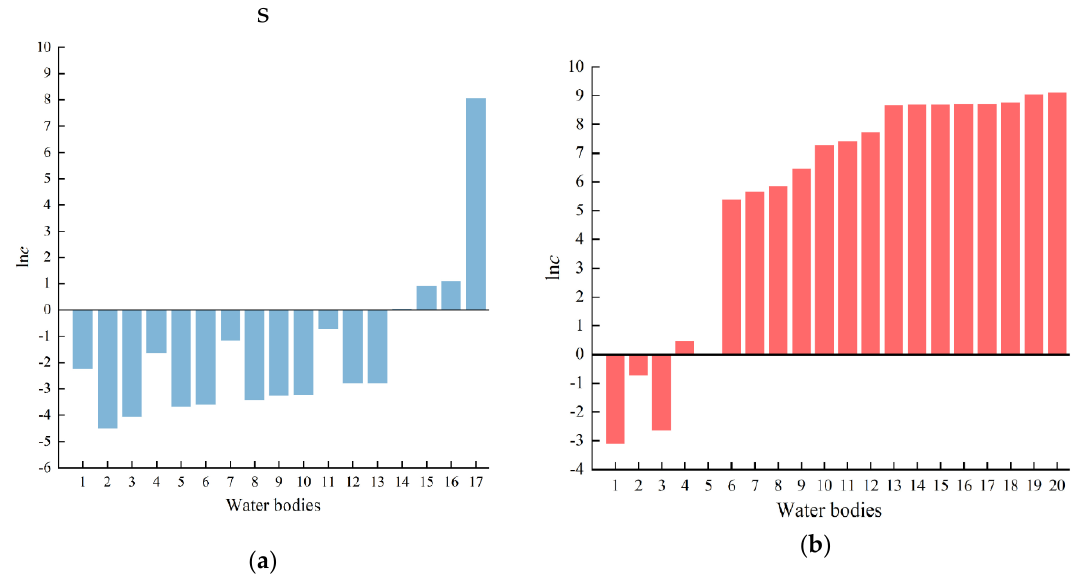
Figure 2. The average content of microplastics in typical freshwater bodies: ( a ) in developed countries; ( b ) in developing countries.